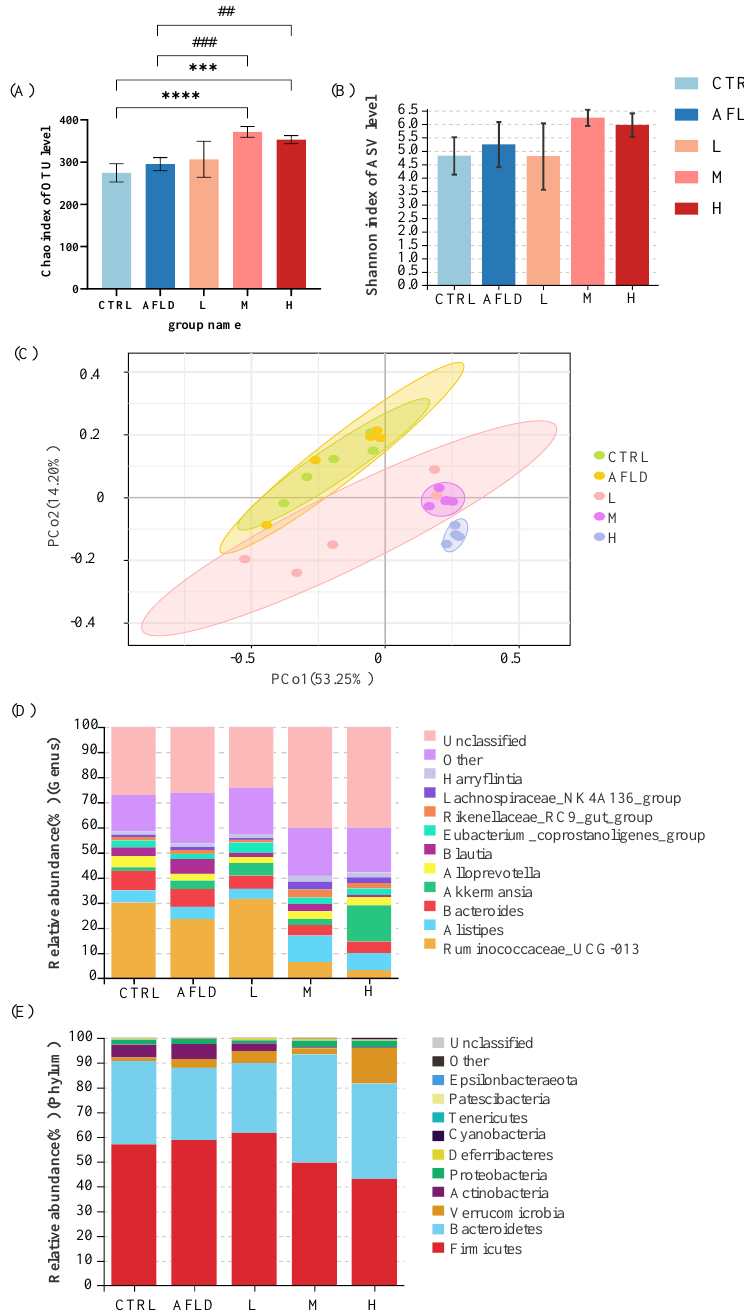
Figure 4. ( A ) The α -diversity representing the Chao index at the OTU level. *** p < 0.001, **** p < 0.001 for the CTRL group compared with the DOFE median supplementary group and the DOFE high supplementary group; ## p < 0.01, ### p < 0.001 for the AFLD group compared with the DOFE median supplementary group and the DOFE high supplementary group. ( B ) Shannon index to evaluate the diversity of microorganisms; ( C ) PCoA plot of the gut microbiota based on Bray–Curtis matrices. Analysis of gut microbiota composition at the phylum level ( D ) and the genus level ( E ). CTRL, the control group; AFLD, the model group; DOFE, Dendrobium officinale flower extract; L, the low concentration of DOFE; M, the medium concentration of DOFE; H, the high concentration of